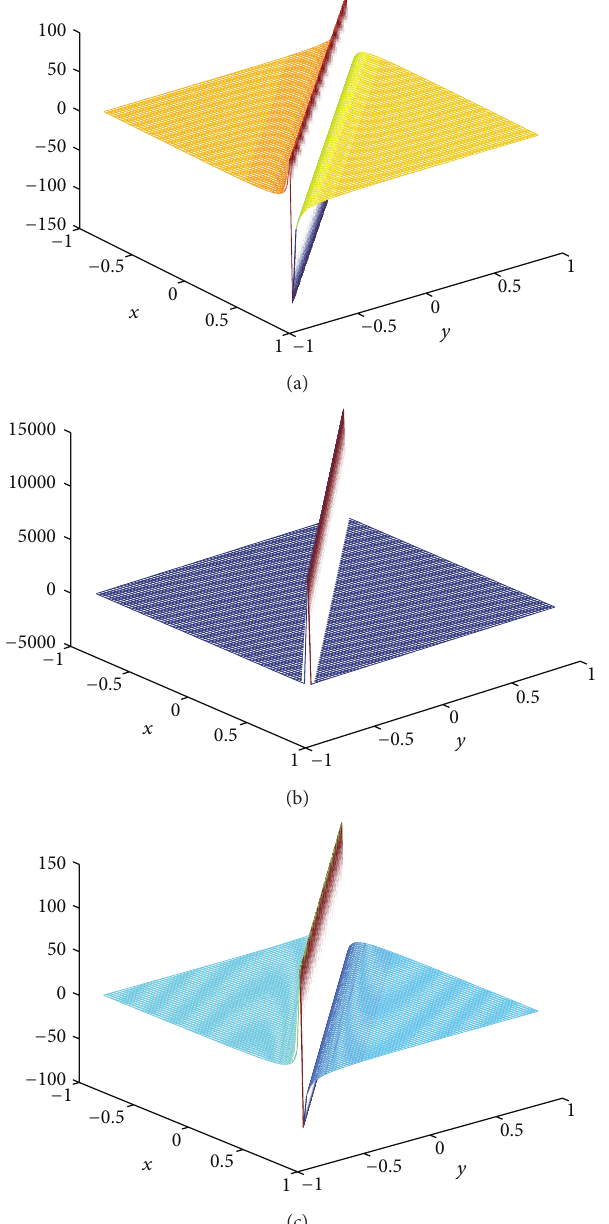
Figure 6: The solution of BLP corresponding to 𝑢 𝑠,6 : take 𝑐 = 1 , 𝛼 = 1 ,